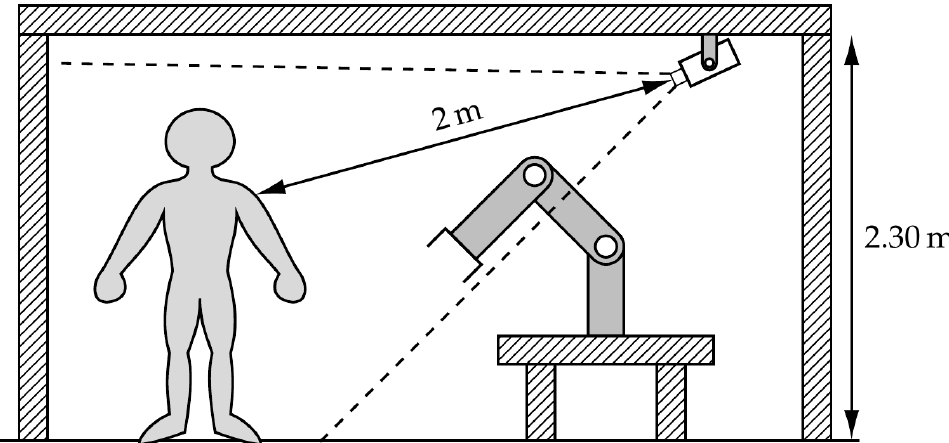
Figure 1. Diagram of the collaborative cell with the robotic arm and the human operator. It includes the representation of the Kinect RGB-D camera with a representation of its field of